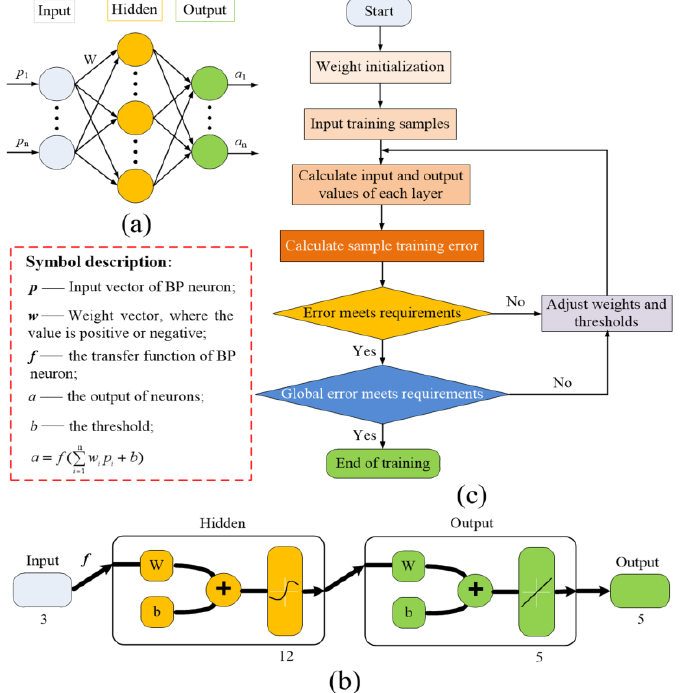
Figure 8. BP neural network: ( a ) single hidden layer, ( b ) network structure and ( c ) learning pro- cedure.